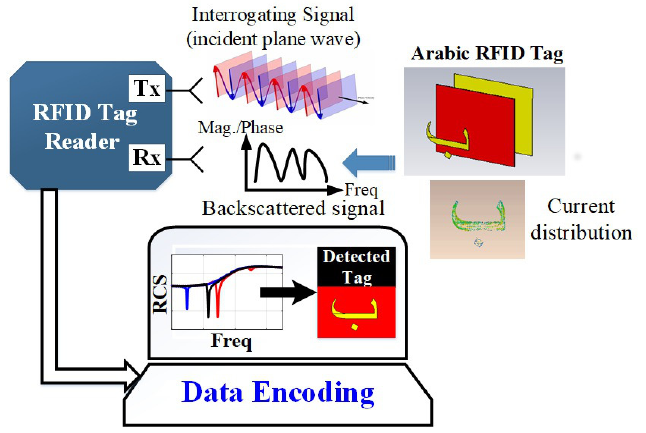
Figure 2. Operation principle of designed chipless Arabic alphabet